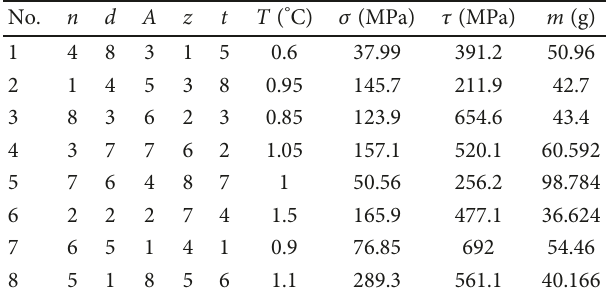
Table 8: Simulation and calculation results of the uniform test. No. n